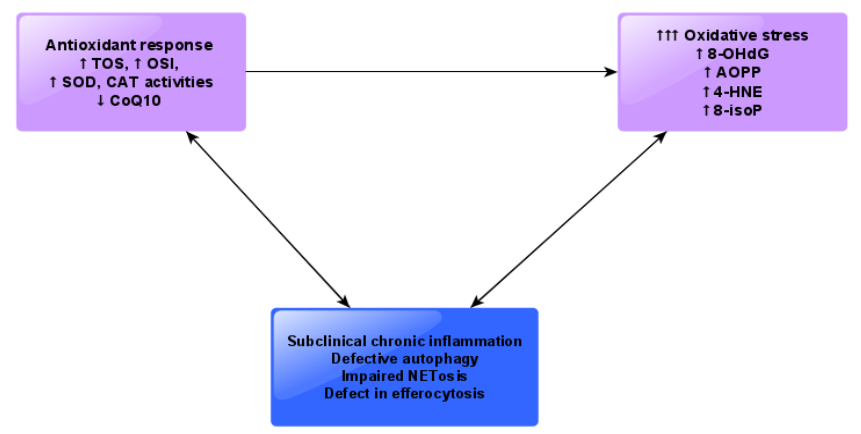
Figure 6. A possible link between antioxidant response, oxidative stress and subclinical chronic inflammation in patients with chronic granulomatous disease (CGD) based on our study. Abbreviations: TOS, total oxidant status; TAS, total antioxidant status; OSI, oxidative stress index; CAT, catalase; SOD, superoxide dismutase; CoQ10, Coenzyme Q10; 8-OHdG, 8-hydroxy-D-guanosine; AOPP, advanced oxidation protein products; 4-HNE, 4-hydroxynonenal; 8- isoP, 8-isoprostanes; AGE, advanced